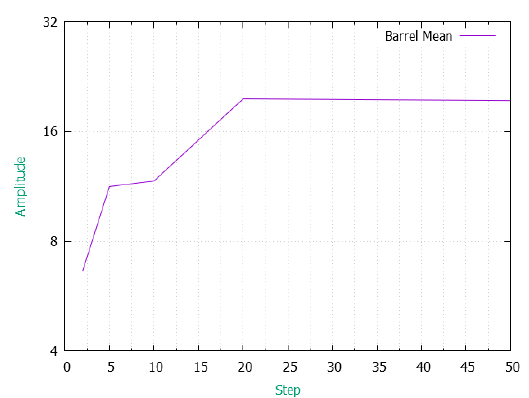
Figure 15. Plot barrel distortion variance 64x64